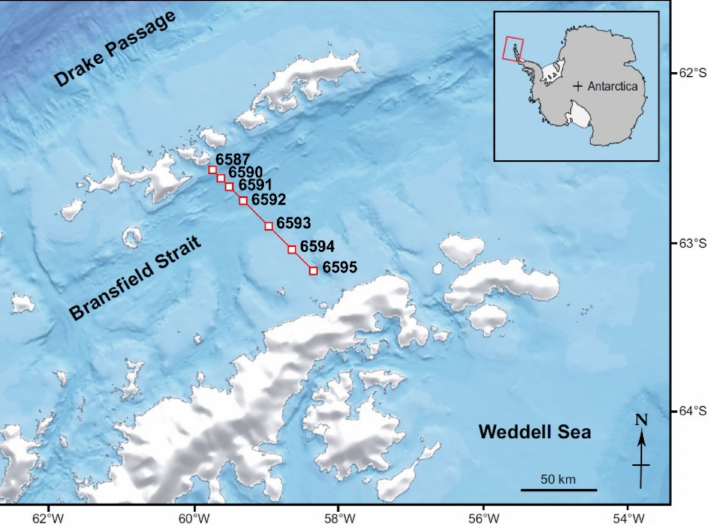
Figure 1. Location of oceanographic stations in the Bransfield Strait (79th cruise of R/V “Akademik Mstislav Keldysh”, January 2020) where water samples were collected at 5 to 7 depths in austral mid-summer.